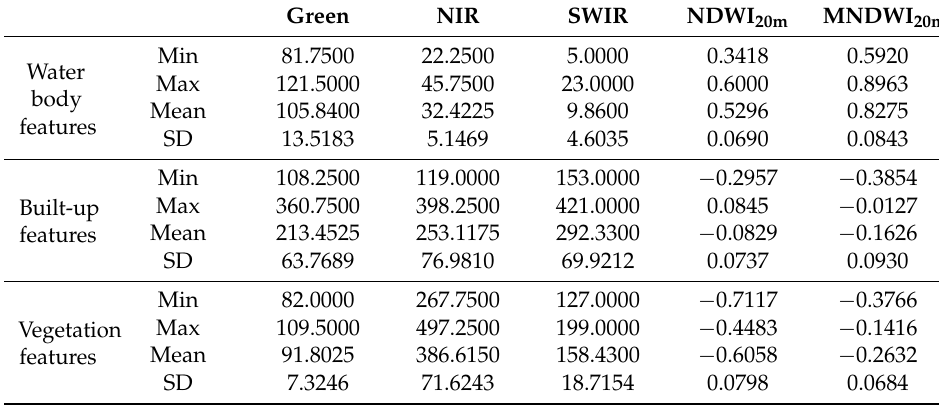
Table 2. Maximum (Max), minimum (Min), mean and standard deviation (SD) values of water body, built-up and vegetation features within the Band 3 (green), Band 8 (NIR), Band 11 (SWIR), NDWI 20m and MNDWI 20m images shown in Figure 1b–d and Figure 2a,b,